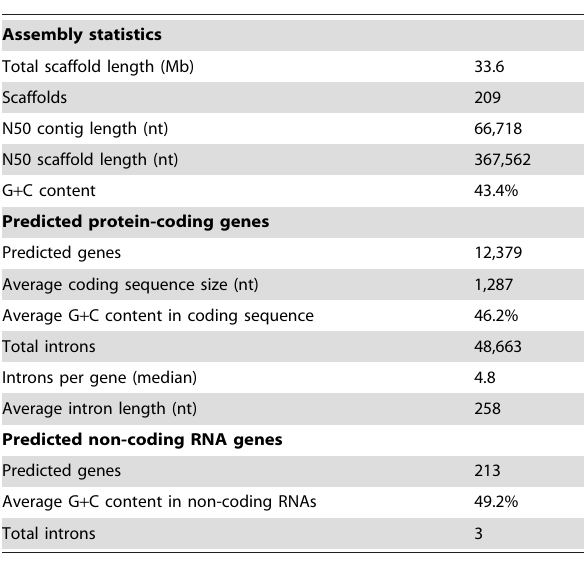
Table 1. Statistics of the L. corymbifera